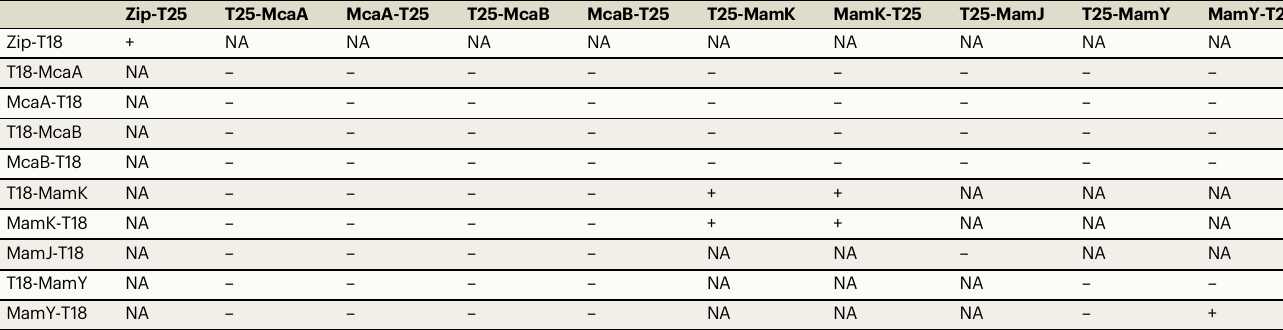
Supplementary Table 3).The t 1/2 fl uorescence recovery is similarin WT and McaAB de fi cient cells containing an immotile bleached spot (Fig. 8f and Supplementary Fig.14a). For theMcaABde fi cient cellswith a moving bleached spot, the t 1/2 fl uorescence recovery of the original bleached area is similar but much faster than in the cells containing an immotile bleached spot (Fig. 8h), indicating a similar moving speed of (Fig. 9a, b) or metagenomes obtained from a magnetic enrichment (Supplementary Fig. 15a, b), with the majority af fi liated to the Rho- dospirillaceae family in the Alphaproteobacteria class. Based on pub-